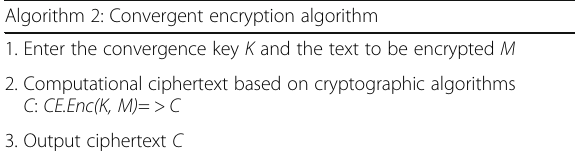
Table 2 Algorithm of encryption Algorithm 2: Convergent encryption algorithm